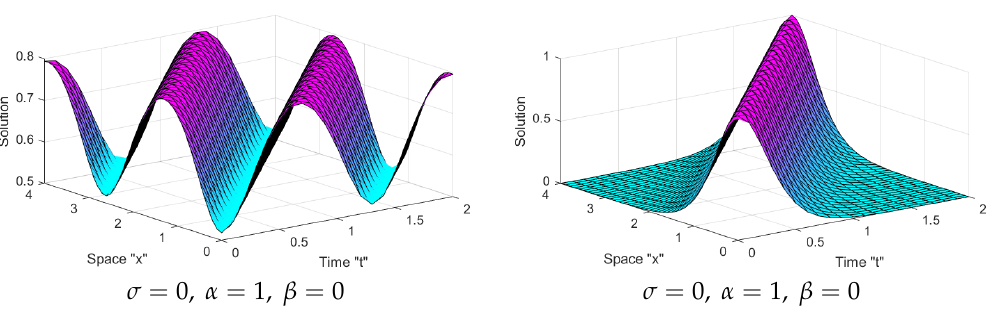
Figure 1. A 3D-plot of the solution ϕ ( x , t ) in Equation (25), which is a singular periodic soliton, and Equation (26), which is a singular and bright soliton.